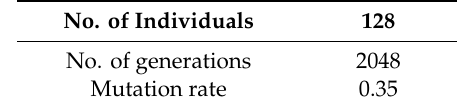
Table 6. Working parameters of the genetic algorithm.